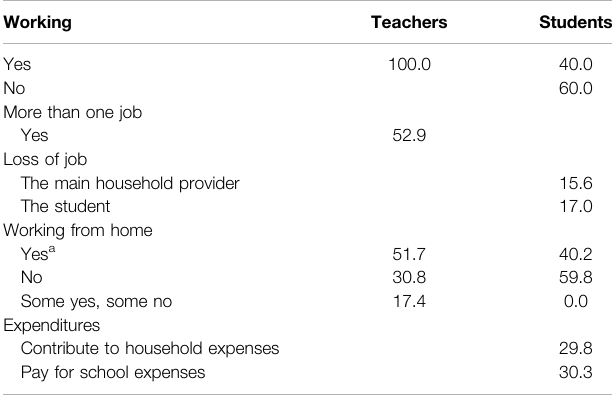
TABLE 3 | Participants job pro fi le and economic